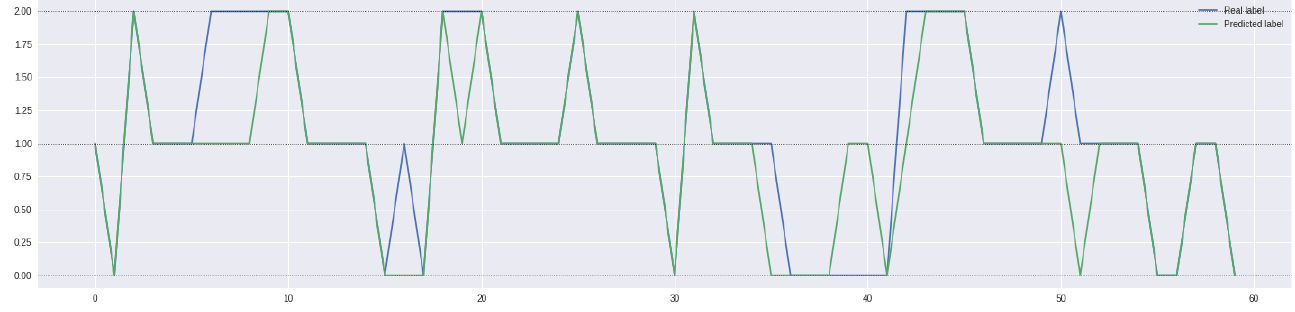
Figure 6. XGBoost predictions for Apple.